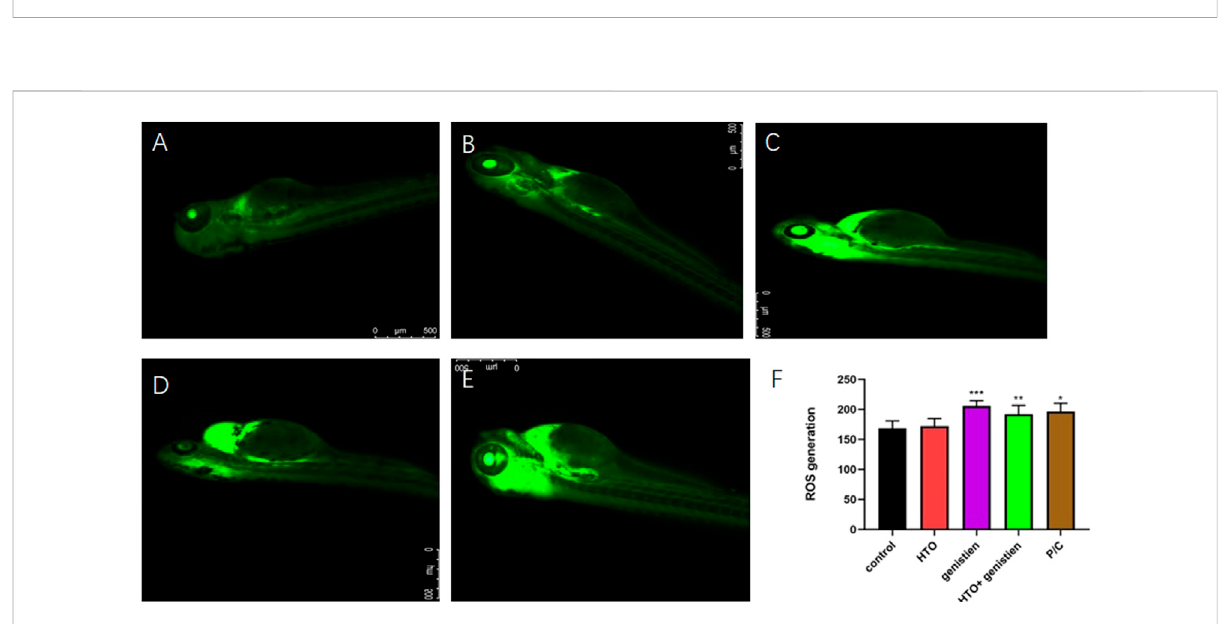
FIGURE 4 Reactive oxygen species (ROS) in 96hpf zebra fi sh larvae. (A) control group; (B) 3.7*10 2 Bq/ml HTO group; (C) 1.4 mg/L genistein group; (D) 3.7*10 2 Bq/ml HTO+1.4 mg/L genistein group; (E) positive control group; (F) the quantity analysis of fl uorescence intensity. 10 samples were taken from each parallel samples of each experimental group. * p < 0.05, ** p < 0.01, *** p <